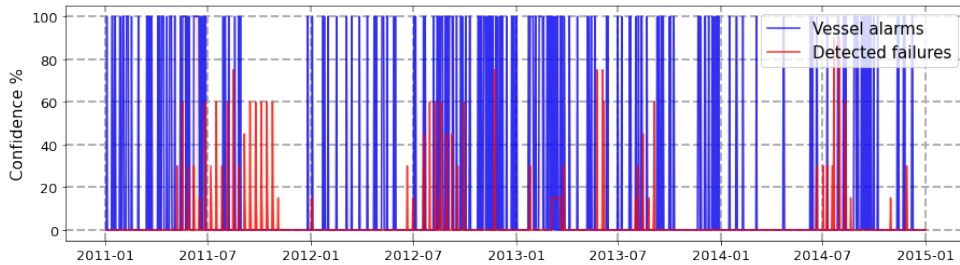
Figure 10. Normalized comparison of the vessel alarms (in blue) with the autoencoder’s joint diagnostics for all failure modes. Data comes from a F-100 class frigate. Y -axis represents the confidence given by the autoencoder. X -axis represents normalized data coming from the